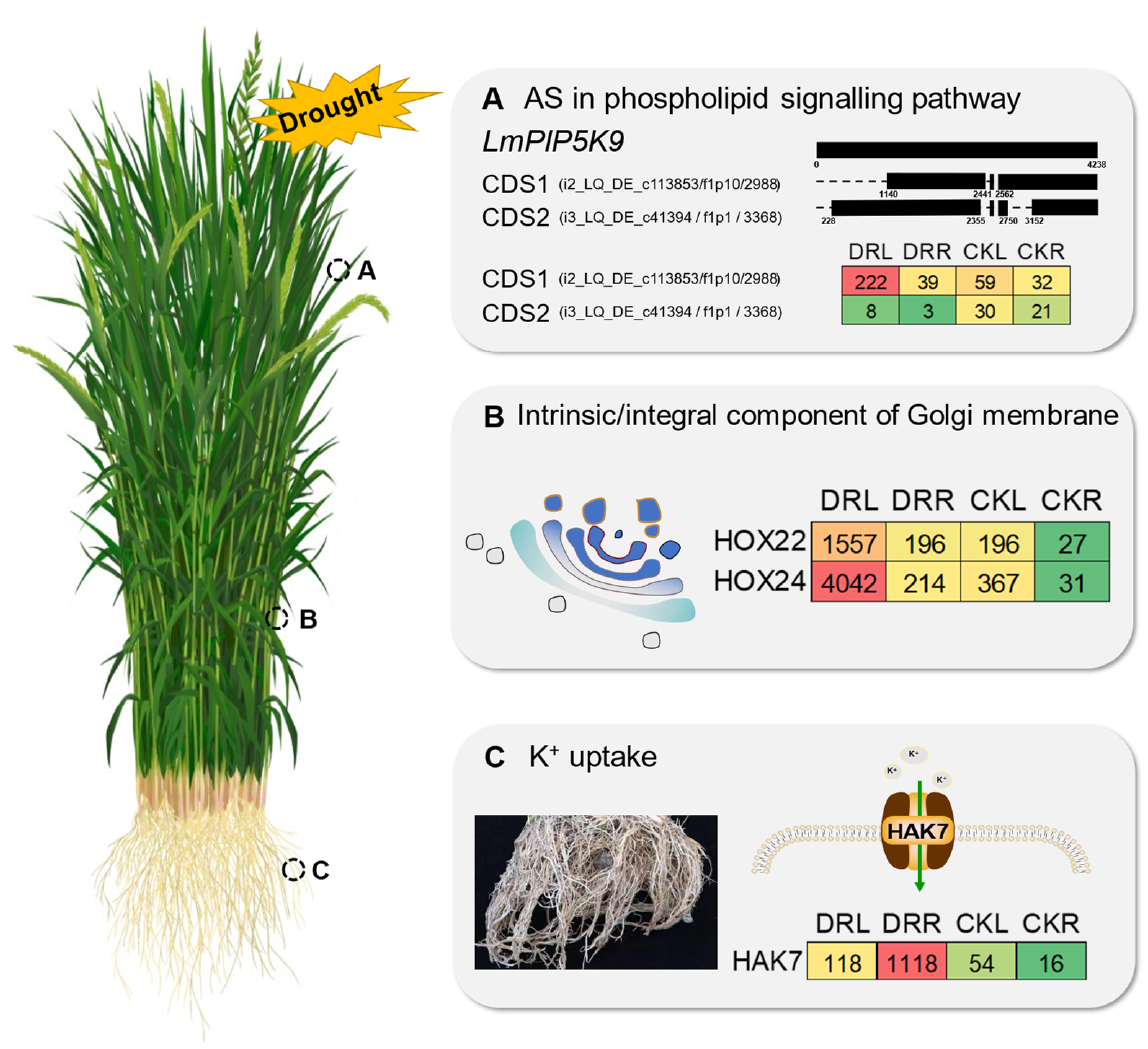
Figure 8. The complexity of transcriptional regulation in the Lolium multiflorum drought response. ( A ) The role of alternative splicing (AS) in the phospholipid signaling pathway. The black bars represent sequences, and the grey dotted lines represent gaps. ( B ) The HOX gene family is highly expressed in leaf tissues under drought and participates in intrinsic/integral components of the Golgi membrane. ( C ) The plant-specific gene HAK was highly expressed in root tissue under drought and is involved in K+ uptake. Red and green represent high and low expression, respectively, and the number in each box represents the corresponding read count.